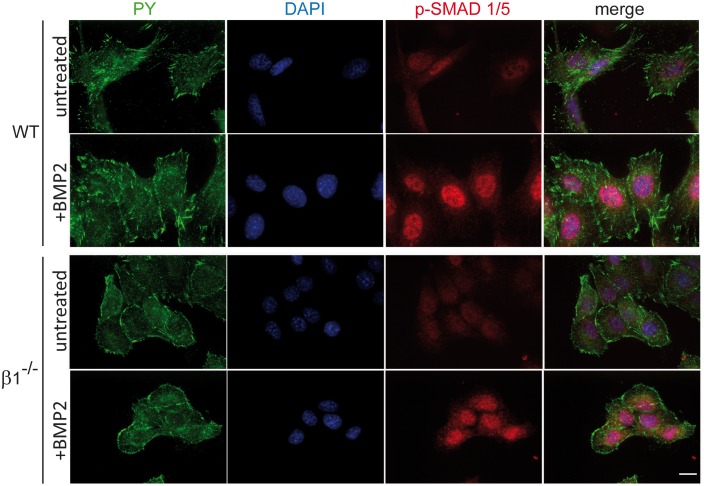
Efficient Smad1/5 nuclear translocation in absence of β1 integrins.Smad1/5 nuclear translocation was analyzed using immunofluorescence under basal conditions (untreated) or after BMP2 treatment (+BMP2; PY: phospho-tyrosine; scale bar represents 10μm). Note the clear P-Smad1/5 nuclear translocation after BMP2 treatment in WT, as well as β1 deleted (β1-/-) osteoblasts.